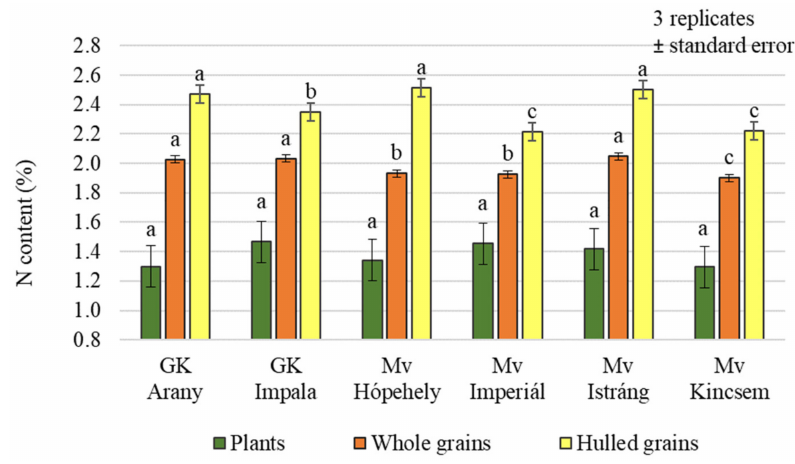
Figure 4. Nitrogen content of the winter oat varieties (plants, whole and hulled grains); ± standard error of means. 3 replicates. The different letters show significant difference between the varieties, separately in different plant samples, at p = 0.05 level.